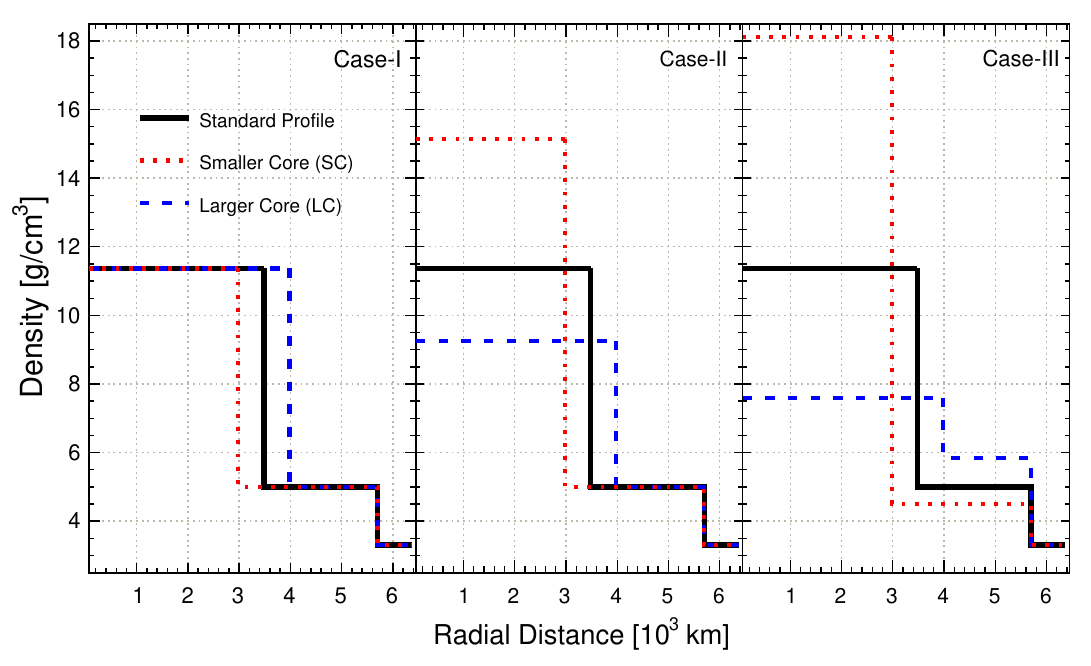
Figure 2 . Densities as functions of radial distance for different ways of incorporating modified CMB in the three-layered profile of Earth. The black curves show the standard density profiles with R = 3480 km. The dotted-red (dashed-blue) curves indicate the density profile in the SC CMB (LC) scenario, where R in decreased (increased) by 500 km. See text (section 3.1) for details CMB of cases I, II, and III.